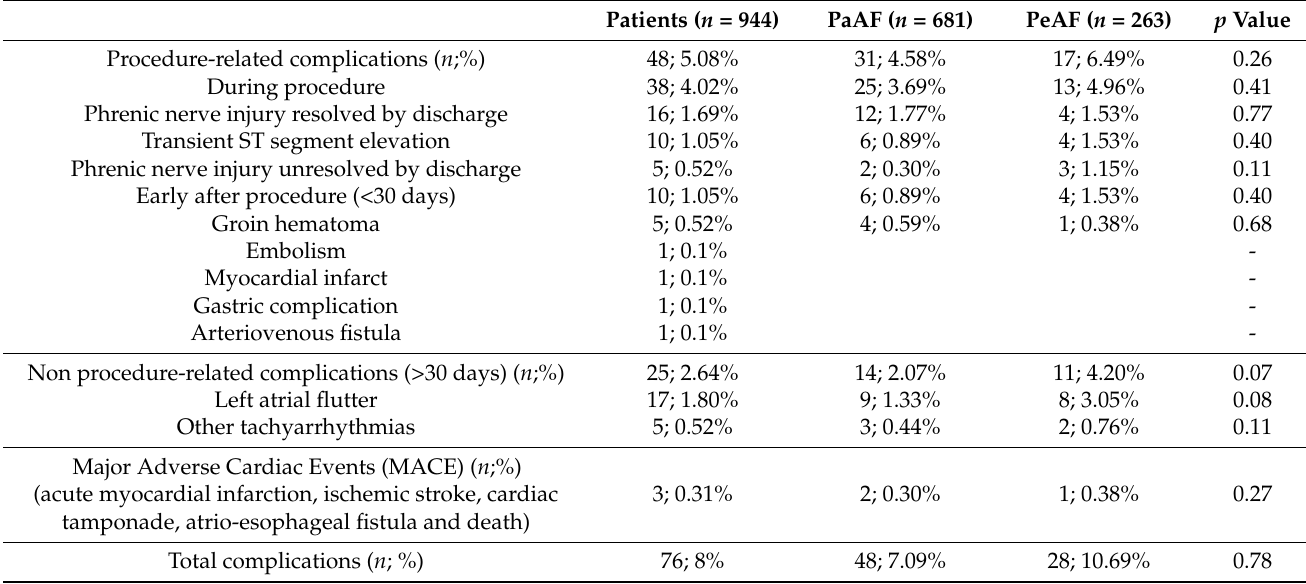
Table 3. Complications: Paroxysmal vs.